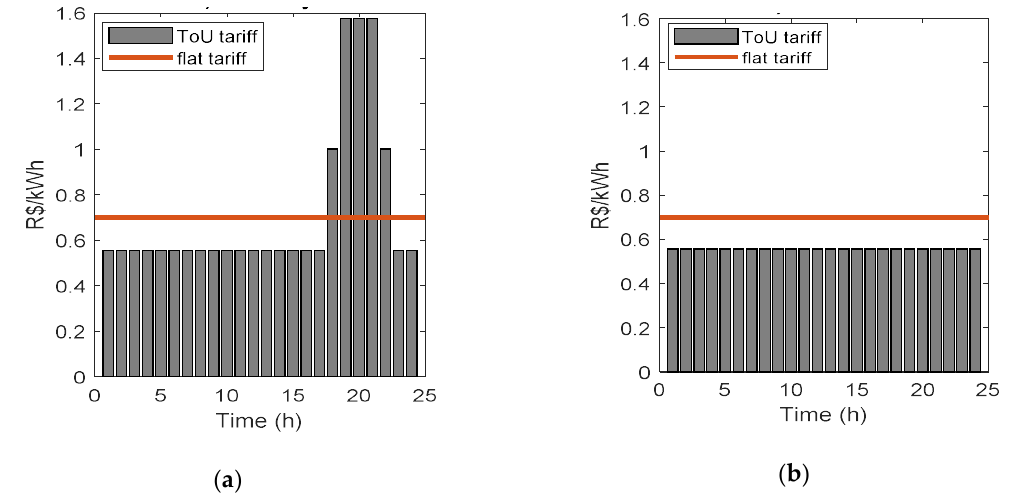
Figure 4. Brazilian flat tariff and White tariff (ToU). ( a ) Weekdays. ( b ) Weekend and national holidays.